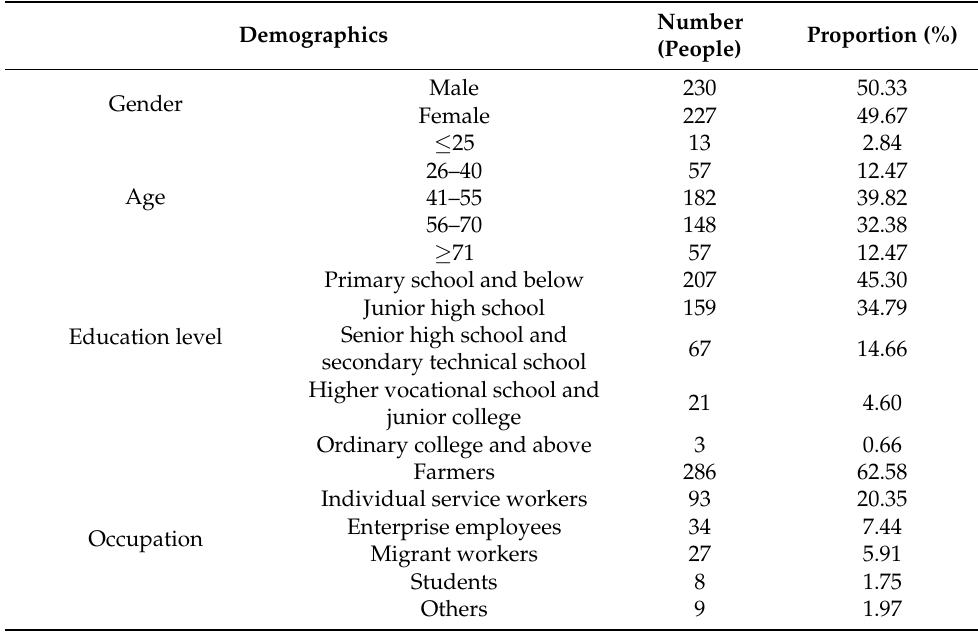
Table 3. Demographics of the